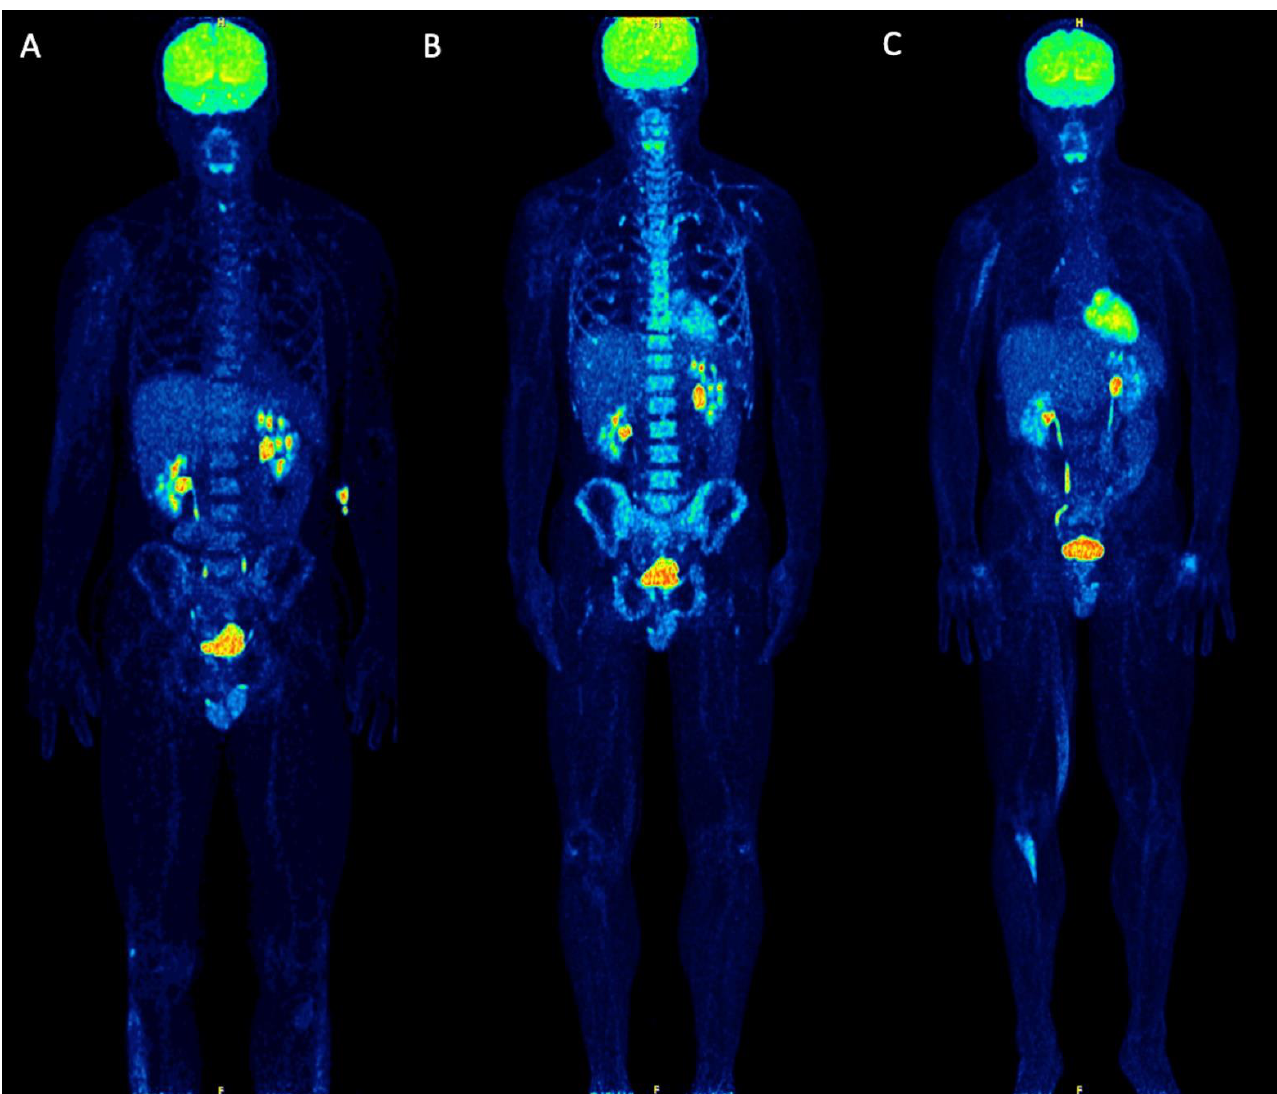
Figure 2. Maximum intensity projection (MIP) 18 F-FDG PET/CT images upon SMM diagnosis ( A ), at transition to symptomatic MM ( B ) and after therapeutic intervention ( C ). Baseline PET/CT upon asymptomatic SMM showed no pathological findings. A discretely increased, diffuse tracer uptake in the bone marrow (≤liver uptake) is observed. The foci of increased 18 F-FDG uptake in the lower abdomen/pelvis correspond to physiological urinary tracer activity in the ureters, while the focal 18 F-FDG accumulation in the right knee joint most likely represents an inflammatory process. Semi-quantitative calculations revealed a SUV mean of the iliac bone of 2.2 (SUV max 3.3). According to the quantitative, pharmacokinetic analysis, the influx of 18 F-FDG in the bone marrow was 0.01 (1/min) ( A ). The first follow-up PET/CT scan at the time of symptomatic myeloma transition (6 months later) revealed an intense, diffuse 18 F-FDG uptake in the bone marrow of the axial skeleton without any focal lesions. SUV mean of the iliac bone increased to 4.0 (SUV max 6.3), while the tracer influx increased to 0.03 (1/min) ( B ). Two months after successful treatment, which involved tandem HDT and ASCT, the patient underwent a second follow-up PET/CT scan. This demonstrated a pronounced remission of the diffuse bone marrow uptake and a reduction of the respective SUV values (SUV mean 1.4, SUV max 1.6) and influx (0.01 (1/min)) of 18 F-FDG. The elongated uptake in the right arm, right thigh and lower leg correspond to muscular activity. Physiological urinary tracer activity is observed in the ureters ( C ).